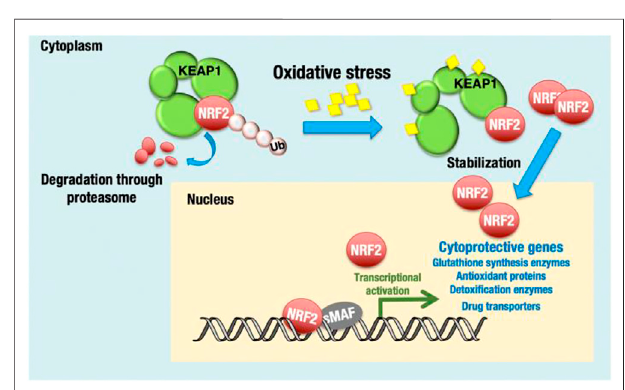
FIGURE3| KEAP1-NRF2systemforoxidativestressresponse.NRF2is a transcription activator and regulates many cytoprotective genes. Under unstressed conditions, Nrf2 is bound by KEAP1 and ubiquitinated for degradation. Adapted from (Okazaki et al., 2020). Under © 2019